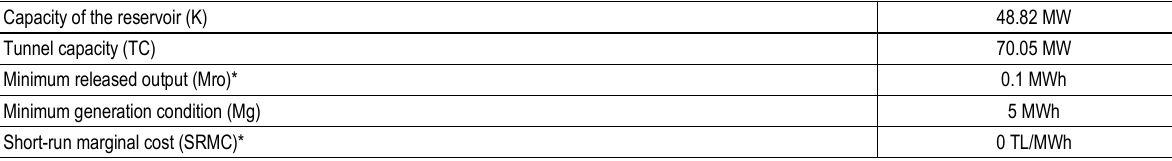
Table 2. Hydro power p lant’s technical properties